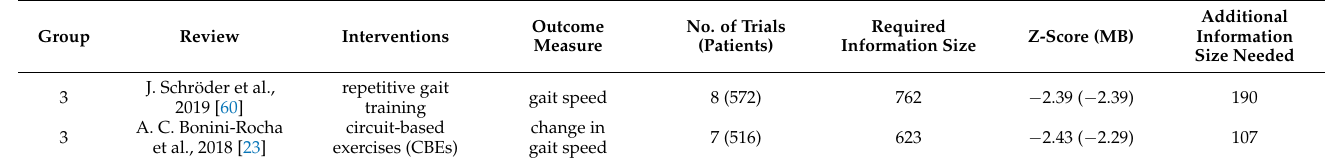
Table 4. Studies with firm evidence of effects on gait speed.